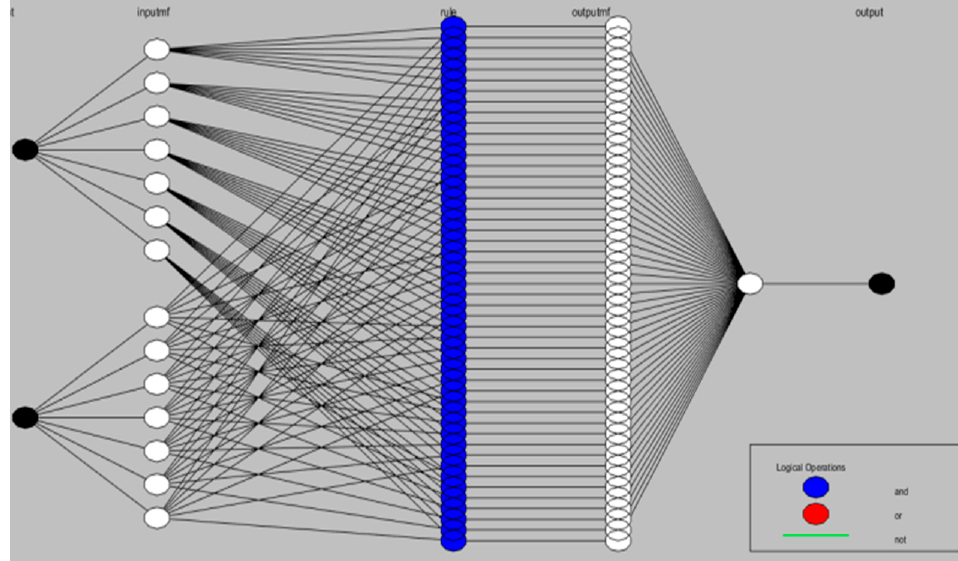
Figure 17. ANFIS Simulink structure.